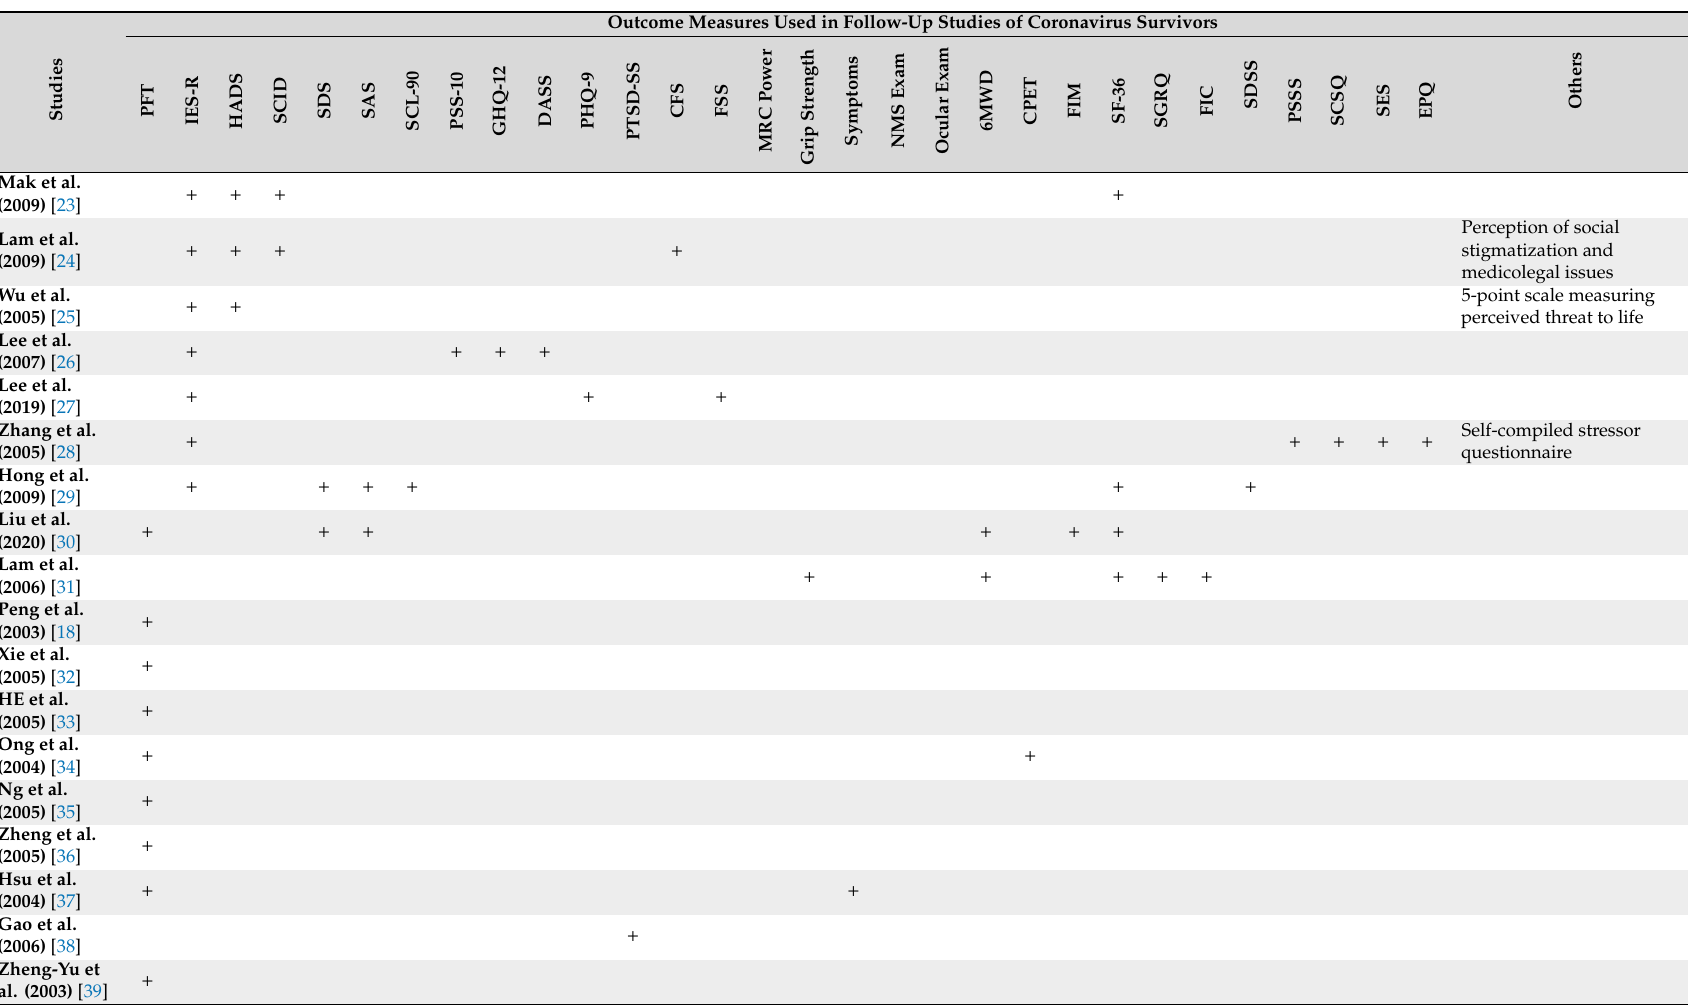
Table 2. Outcome measures used in follow-up studies of coronavirus